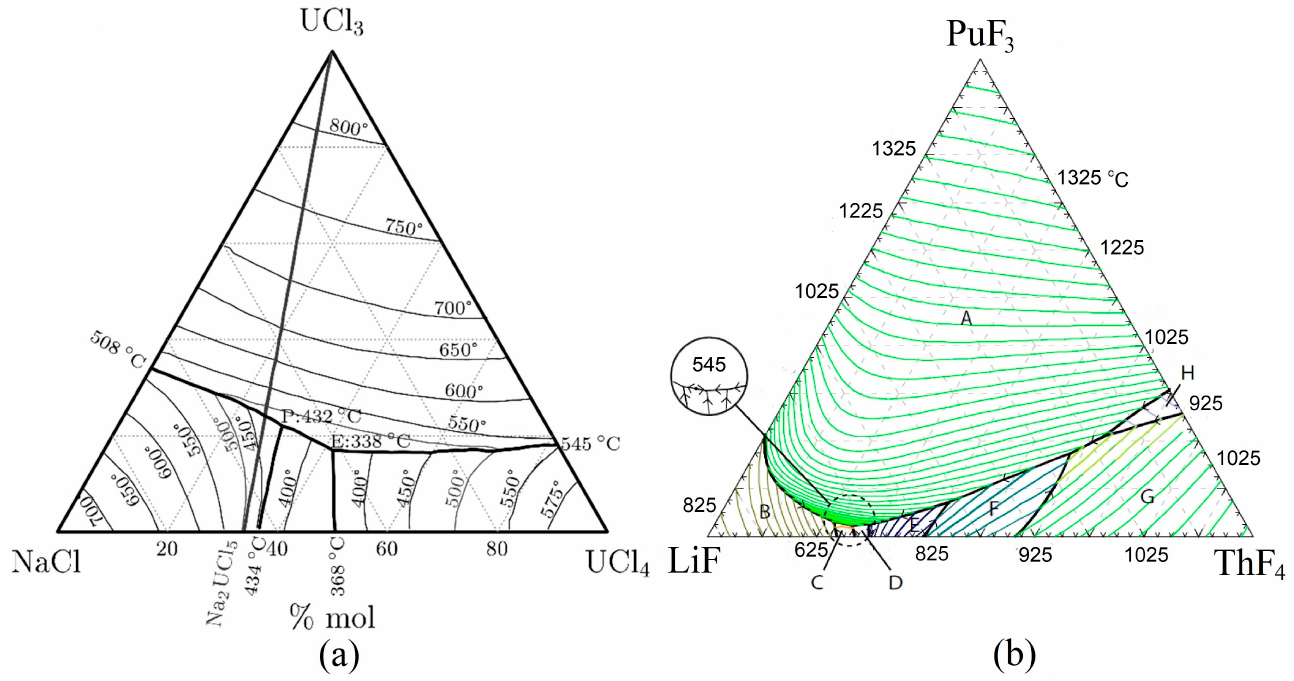
Figure 2. Thermodynamic liquid projections of ( a ) NaCl-UCl 3 -UCl 4 and ( b ) LiF-ThF4-PuF3 (primary crystallisation phase fields: (A) (Pu,U) F x (ss); (B) LiF; (C) Li 4 UF 8 ; (D) Li 7 U 6 F 31 ; calculated LiU 4 F 17 ; (F) UF 4 ; (G) PuU 2 F 11 ). Table 4. Invariant equilibria and saddle point of LiF-ThF4-PuF3 salt fuel system. LiF ThF